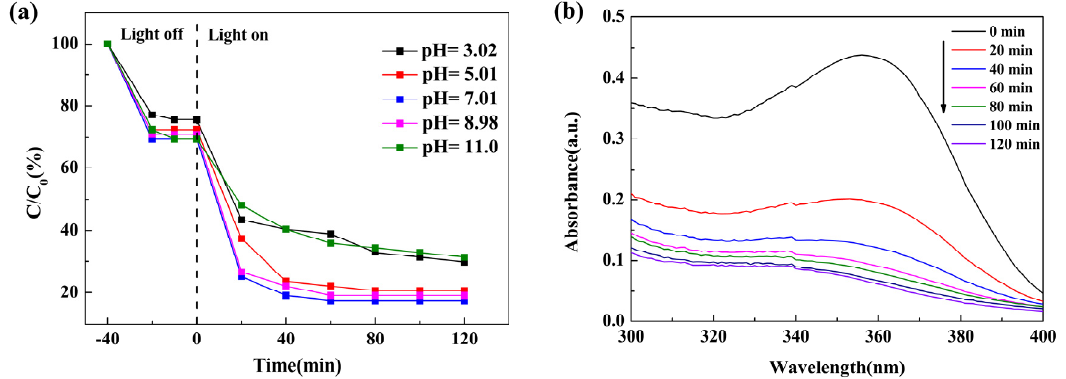
Figure 10. ( a ) Photodegradation a of different initial pH, ( b ) the UV–Vis absorption spectrum of 20 mg/L TC on the novel visible-light-driven photocatalytic system (0.320 g/L of 80ZIS/CN). Figure 10b shows the UV–visible spectrum of the TC solution under optimal